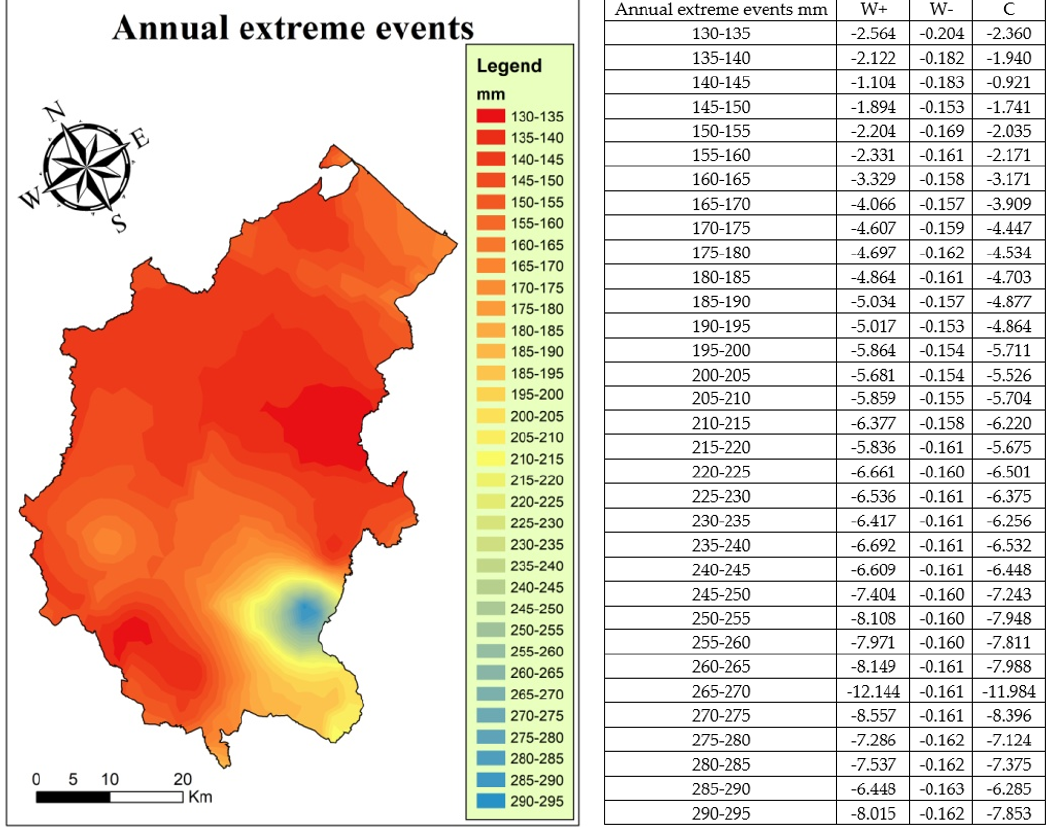
Figure 8. ( Left ) Annual average precipitation in Macerata Province; ( Right ) The weights calculated for annual average precipitation parameter.